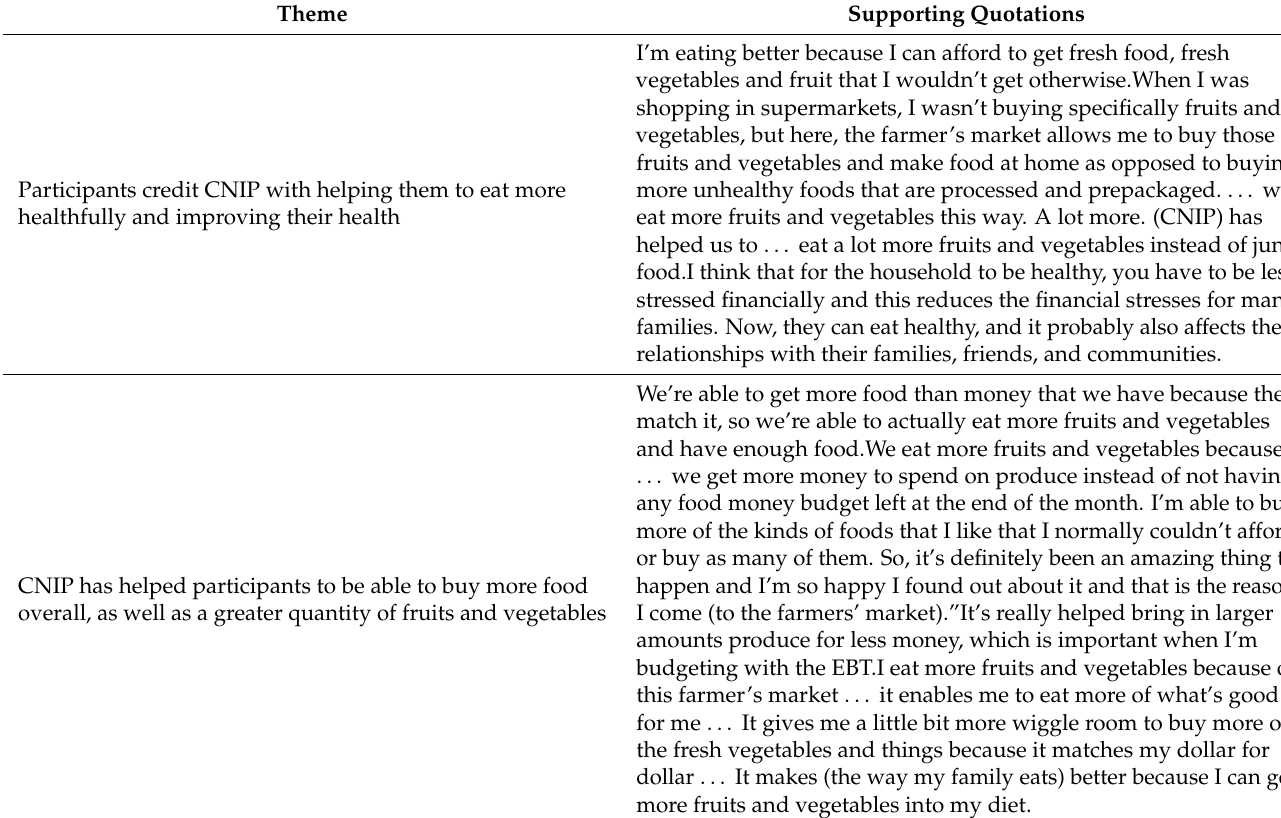
Table 4. Themes, frequencies, and sample quotes to illustrate themes that emerged from qualitative analysis of a subsample of California Nutrition Incentive Program (CNIP) participants completing an open-ended survey module during the CNIP evaluation study ( n =